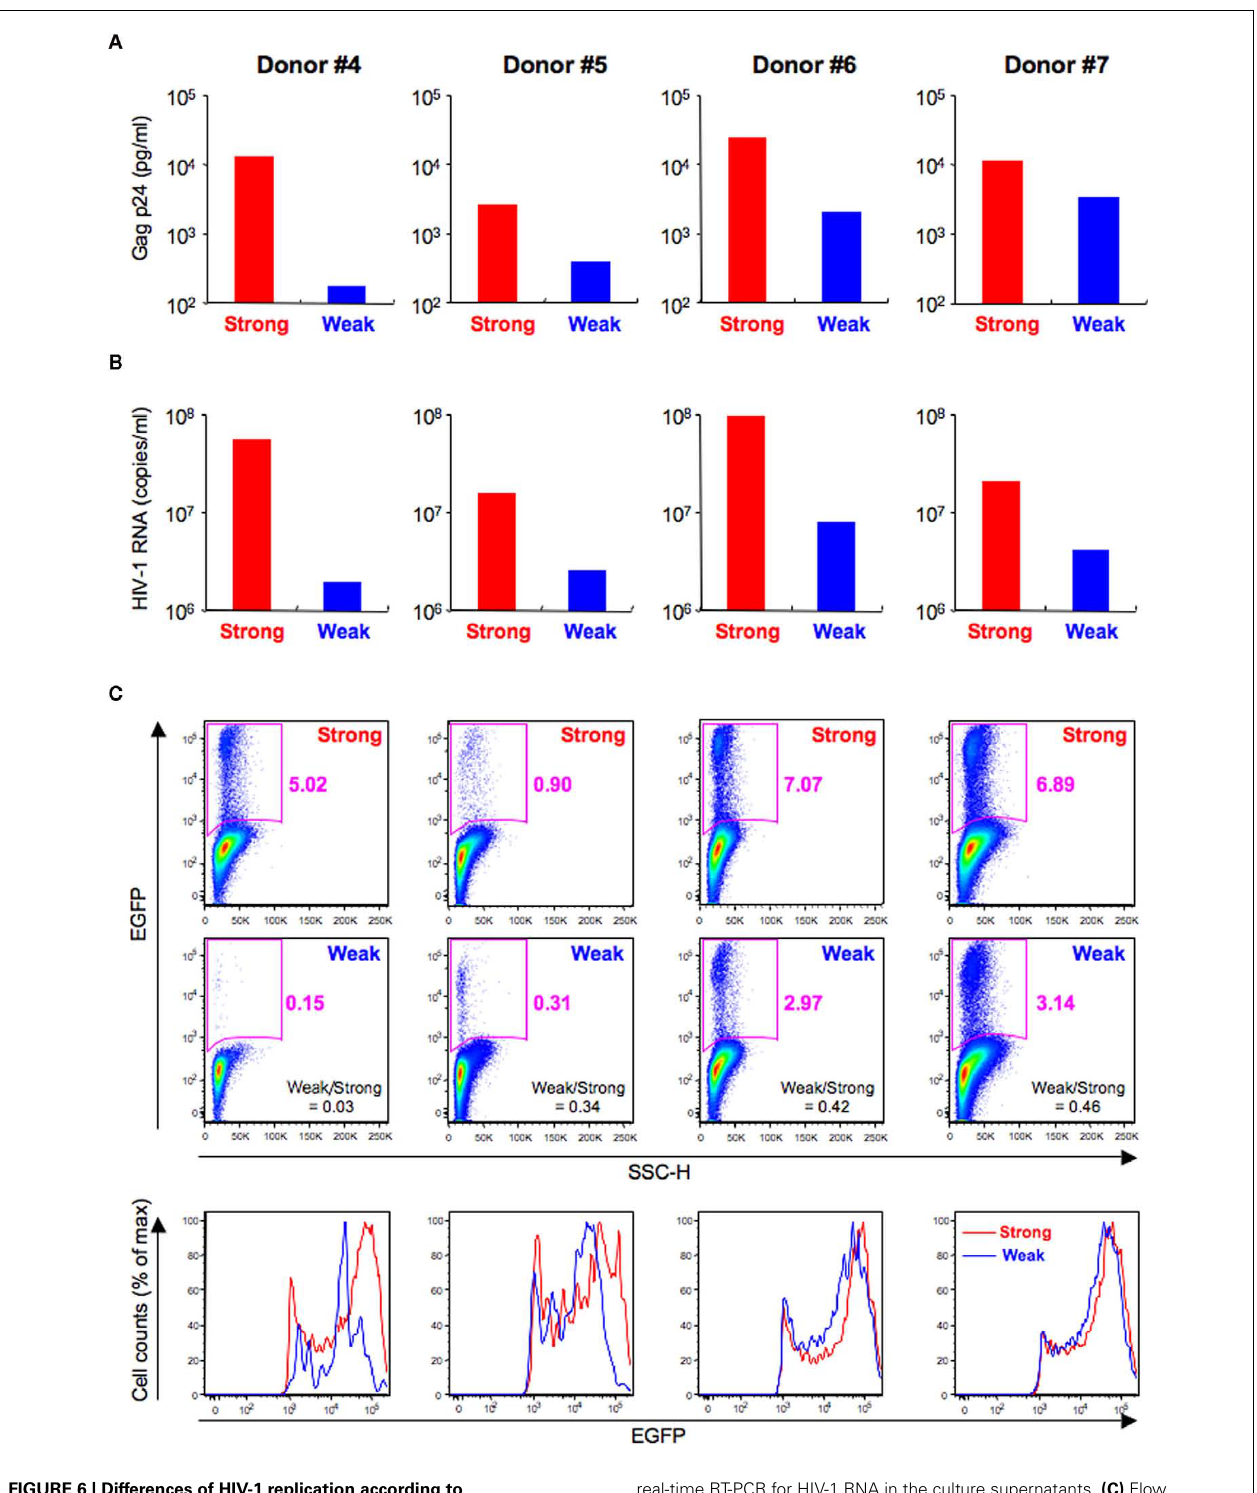
FIGURE 6 | Differences of HIV-1 replication according to TCR-mediated activation levels. Primary CD4 + T cells from four donors (Donor #4–7) were pre-stimulated viaTCR for 4 (Weak; blue) or 24h (Strong; red) and then infected with HIV-1 NL-E and cultured for 3days. (A) ELISA for HIV-1 Gag p24 in the culture supernatants. (B) Quantitative